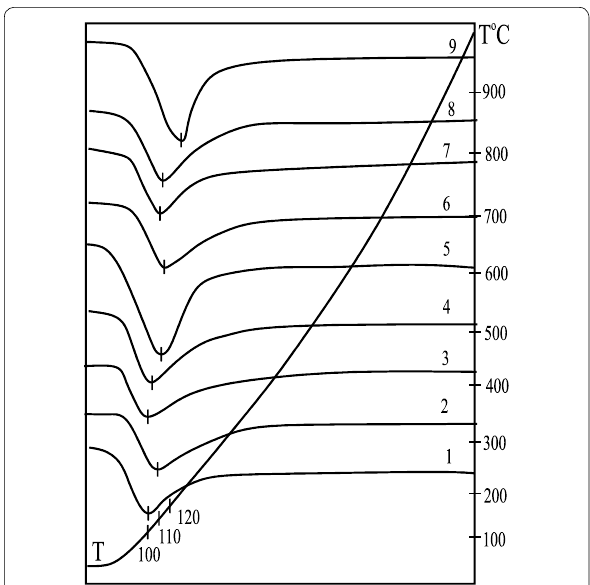
Fig. 3 TGA curves for natural ( 1 ) and acid-modified 0.25H-CLI ( 2 ), 0.5H-CLI ( 3 ), 1H-CLI ( 4 ), and 3H-CLI ( 5 ) clinoptilolite samples as well as: Pd(II)–Cu(II)/0.25H-CLI ( 6 ), Pd(II)–Cu(II)/0.5H-CLI ( 7 ), Pd(II)–Cu(II)/1H-CLI ( 8 ), and Pd(II)–Cu(II)/3H-CLI ( 9 ) catalysts